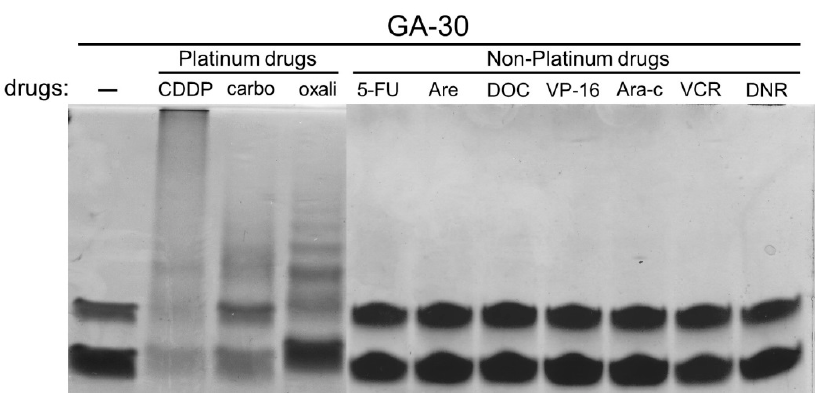
Figure 5. The binding affinity of the GA-30 domain to other chemotherapy agents. Ten micrograms of the GA-30 peptide was individually incubated with 1 mM CDDP, 1 mM carboplatin (carbo), 1 mM oxaliplatin (oxali), 1 mM 5-fluorouracil (5-FU), 0.5 mM arecoline (Are, the irrelevant control), 1 mM docetaxel (DOC), 1 mM etoposide (VP-16), 0.5 mM cytarabine (Ara-c), 1 mM vincristine (VCR) and 0.5 mM daunorubicin (DNR) at room temperature overnight. The reactions were analyzed by Tris-Tricine SDS-PAGE and Coomassie blue staining.